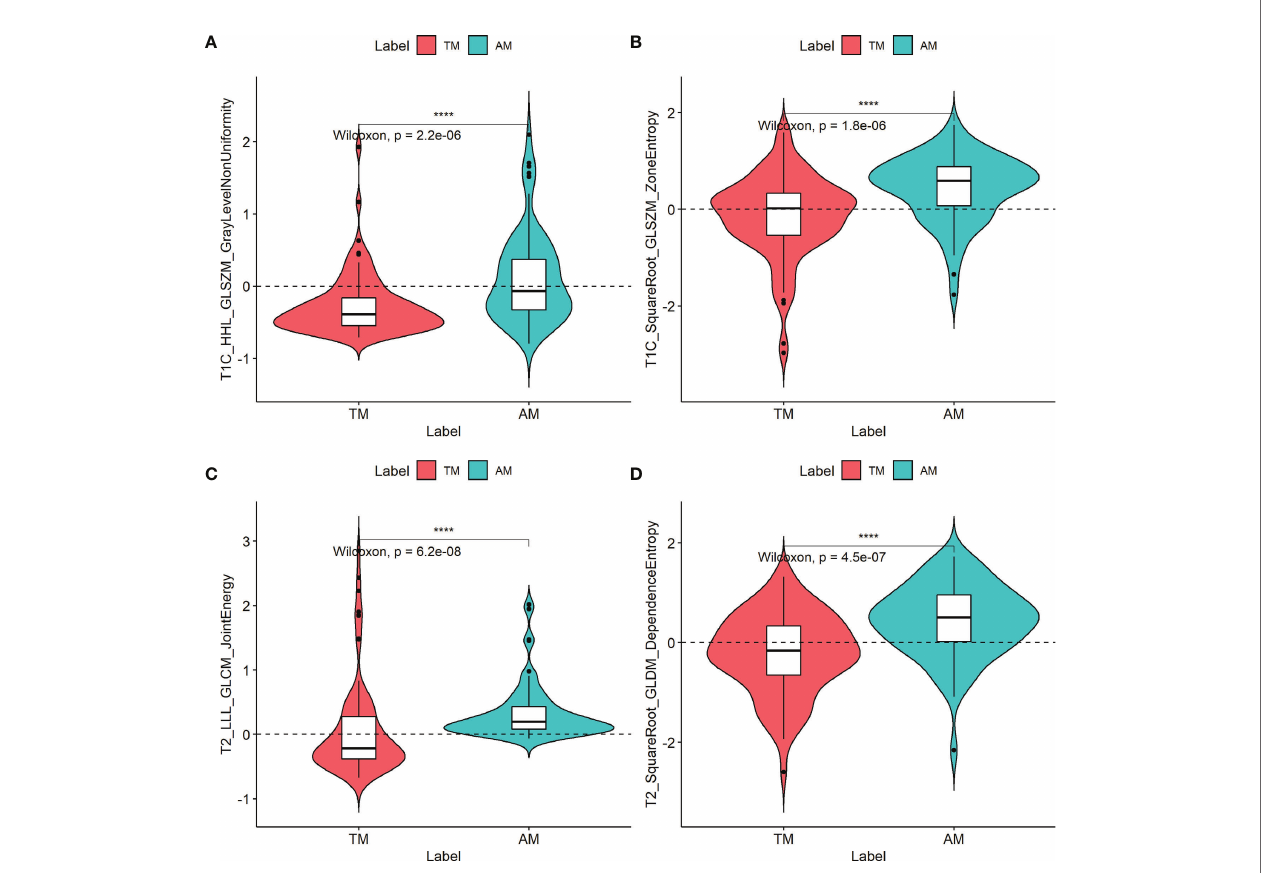
FIGURE 2 | Boxplots of the four radiomic features (A – D) with signi fi cant differences between transitional meningioma (TM) and atypical meningioma (AM) groups in the training cohort. The symbol **** represents p <